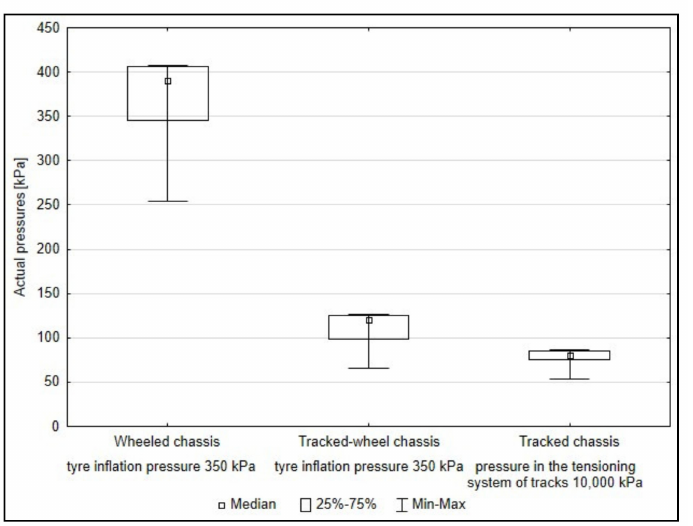
Figure 6. Range of values of induced actual pressures of rear axles in the respective forwarder chassis variants with the load during the first 10